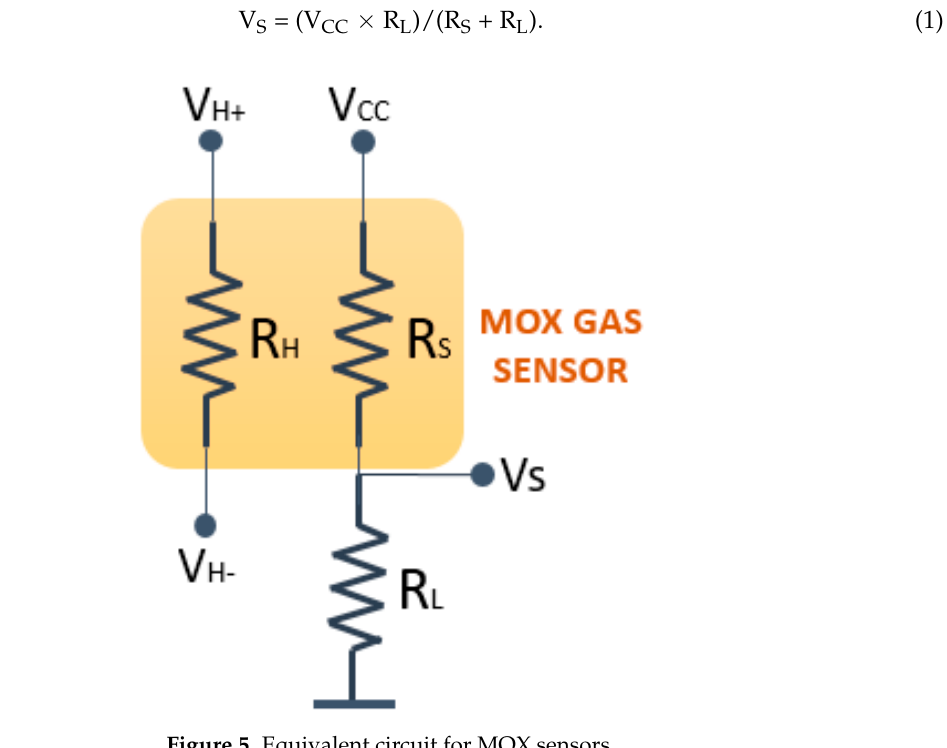
Figure 5. Equivalent circuit for MOX sensors.